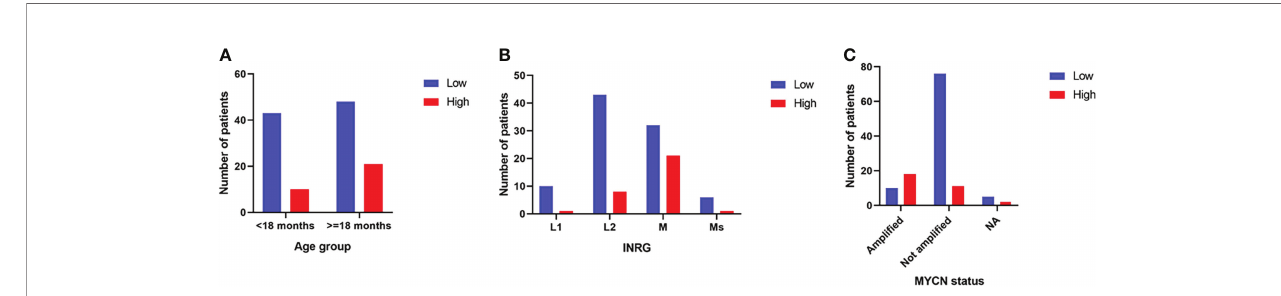
FIGURE 5 | Bar plots of the distribution of 3-O-Methyldopa expression in the second cohort. The bar plots show the number of patients with low (blue) or high (red) 3-O-Methyldopa expression in the subsets of patients de fi ned by: (A) age at diagnosis, (B) INRG stage and (C) MYCN status. Age at diagnosis was split into two groups, one >=18 months and the other <18 months to simplify the analysis. NA stands for not accessible value. Low and high 3-O-Methyldopa expression is displayed in the legends.